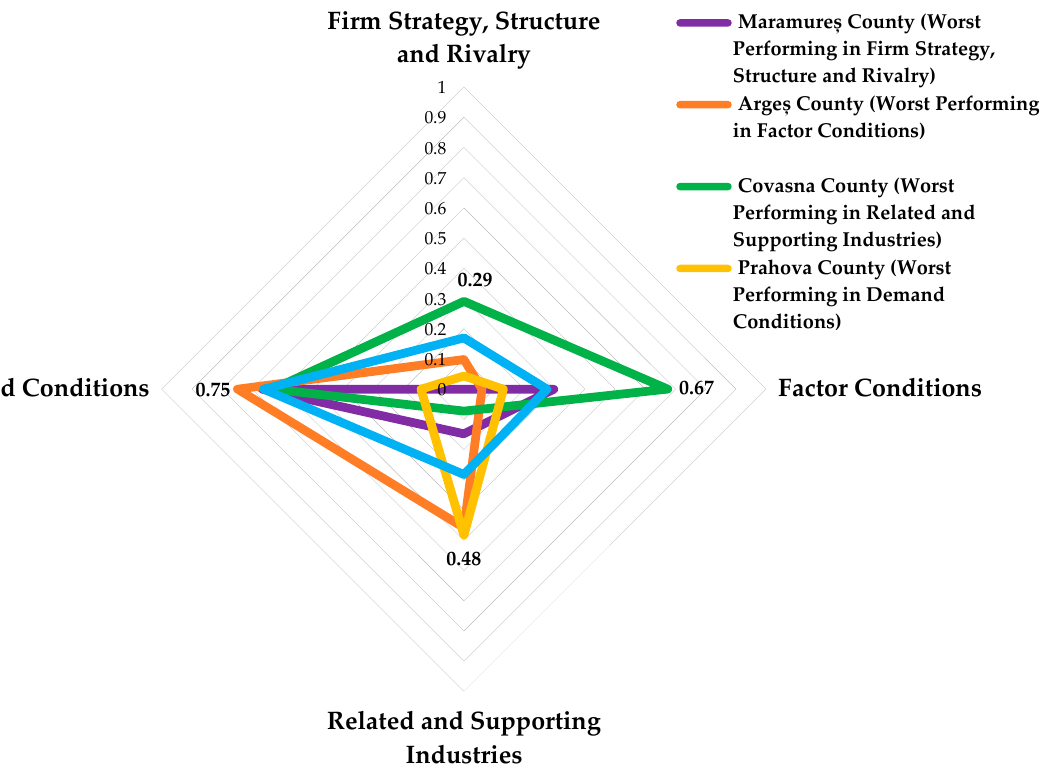
Figure 6. Worst-performing Romanian counties in relation to Porter’s diamond model attributes. Source: authors’ own graphical representation based on data from Table 8.